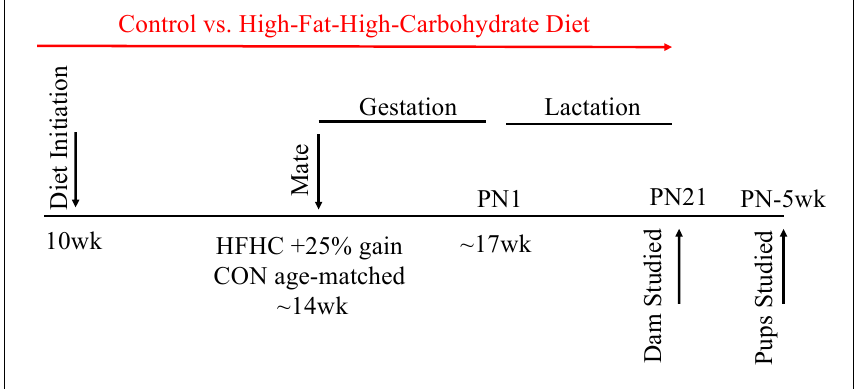
Figure 1. Experimental Animal Model. Female, ~10-week-old, C57Bl / 6J mice were fed ad libitum, either a control or a high-fat–high-carbohydrate (HFHC) diet. Age-matched CON and HFHC females were mated once the females in the HFHC group gained 25% of their initial body weight (~14–16 weeks of age). Pregnant dams (CON N = 16, HFHC N = 15) delivered spontaneously. Litters (CON N = 16, HFHC N = 15) were culled to equal size for the lactation period. Animals were maintained on their respective diets throughout gestation and lactation. Pups were weaned at postnatal (PN) day 21 and acclimated to standard chow. Male and female pups were studied at 4–6 weeks of age. control (CON), high-fat–high-carbohydrate